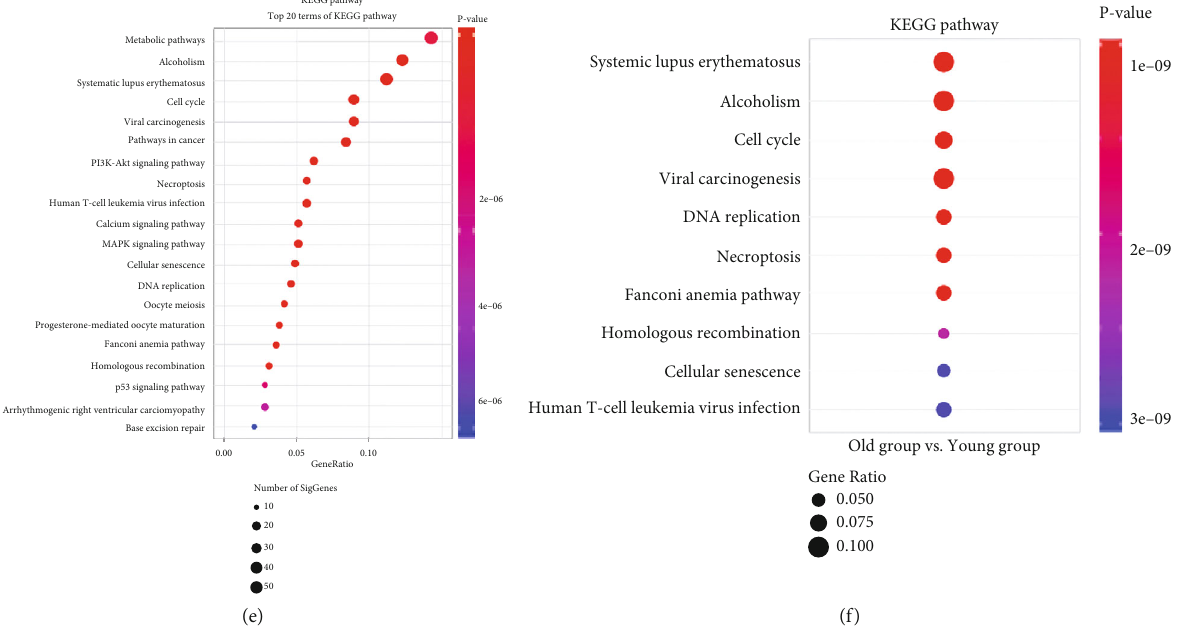
Figure 3: Transcriptomic pro fi les of young and old TMSCs. Whole-genome sequence data from young and old TMSCs are presented. (a) A cell cycle-related partial heatmap of hierarchical clustering analysis results indicates di ff erentially expressing genes (rows) between the young and old TMSCs. Blue and orange circles indicate up- and downregulated genes, respectively, in old TMSCs compared with young TMSCs. For all comparisons, changes in gene expression are depicted as a heatmap. (b) 3D MDS plots for microarray gene expression data compared to young and old TMSCs were presented. (c) 3D dendrogram depicts the results of hierarchical clustering analysis of the interclass correlation between young and old TMSCs, con fi rming the classi fi cation of an interclass between the two groups. (d) The molecular function distribution of GO terms for DEGs between young and old TMSCs was annotated according to the ontology categories: molecular function (MF). The x - and y -axes indicate the number of DEGs and GO term gene classi fi cation, respectively ( ∗∗∗ p < 0 : 001 ). (e) All KEGG pathways were fi rst classi fi ed into 10 categories. (f) These categories were the top 20 terms of the KEGG pathway according to the level of signi fi